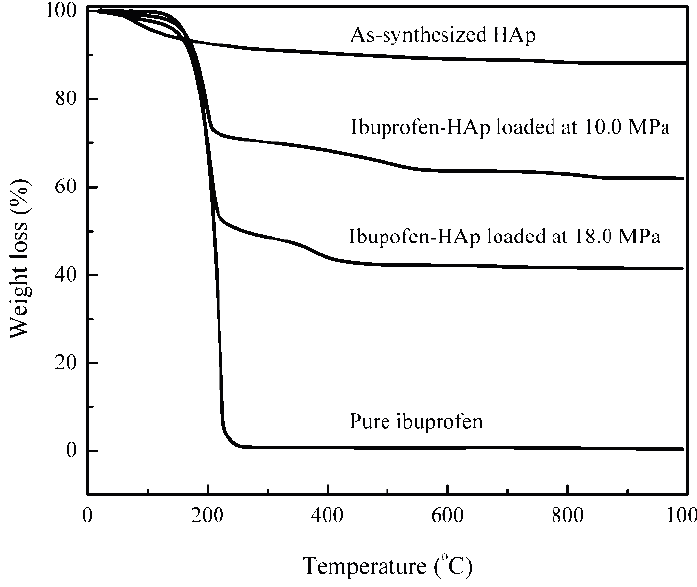
Figure 4. TG curves for the as-produced HAp, pure ibuprofen and ibuprofen loaded samples. In the case of the higher pressure loading at 18.0 MPa, the TG curve provided that W HAp = 8.3% × m T ( m T is the weight of the ibuprofen-HAp sample) and W HAp-Ibu = 49.4% × m T from RT to 250 °C; the curve also provided that W Hap = 3.4% × m T and W HAp-Ibu = 9.0% × m T from 250 to 800 °C. The final weight loss of the ibuprofen-HAp sample is 58.5% from the TG curve; therefore, m HAp = 41.5% × m T . Accordingly, l Ibu,s = 0.99 g ibuprofen/g HAp and l Ibu,i = 0.16 g ibuprofen/g HAp. Note that over 86% of the total ibuprofen loaded was located on the surface of the HAp particles but that the loading may be both adsorption and agglomeration. Clearly, the amount of ibuprofen loaded from the TG analysis (0.99 + 0.16 = 1.15 g ibuprofen/g HAp) is approximately in agreement with the amount of ibuprofen from the UV analysis (1.38 g ibuprofen/g